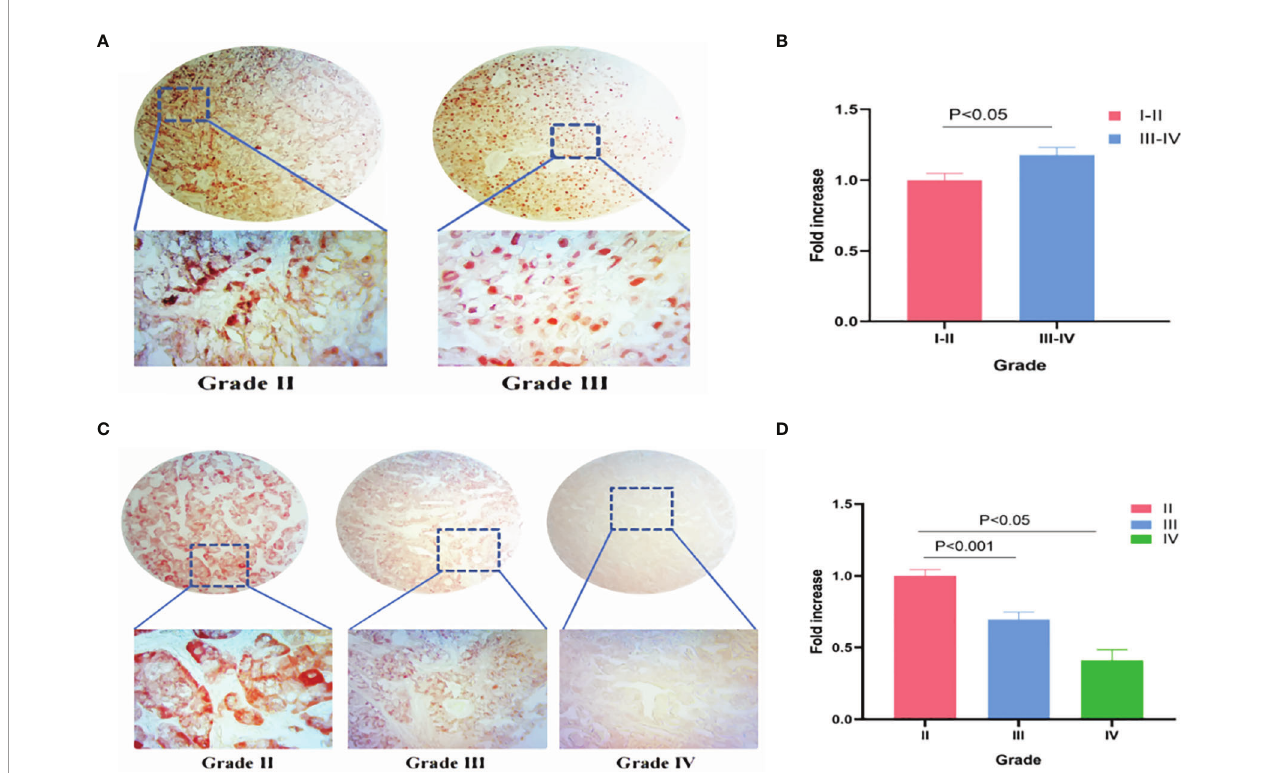
FIGURE 14 | TRPM8 expression in human KIRC and LIHC tissues. (A) IHC staining for TRPM8 in KIRC tissues. (B) Comparative statistical analysis of TRPM8 levels measured as staining intensity in different grades of KIRC tissues. (C) IHC staining for TRPM8 in LIHC tissues. (D) Comparative statistical analysis of TRPM8 levels measured as staining intensity in different grades of LIHC